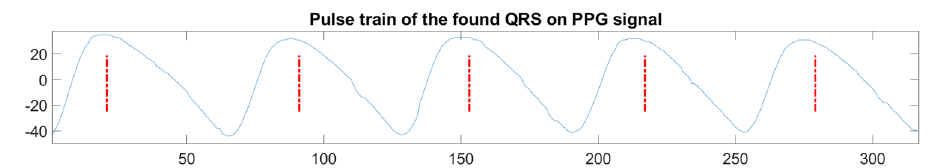
Figure 1. Perfusion peaks of a PPG signal extracted with the PT algorithm (red dashed